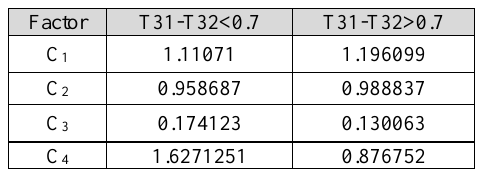
Table 3. Coefficients for the MODIS Band 31 and 32 SST retrieval algorithm, derived using radiosondes to